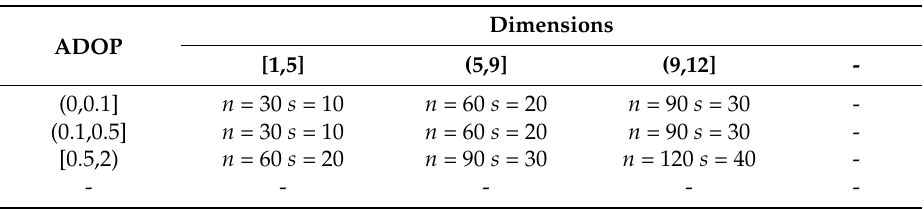
Table 4. Recommended parameter setting for